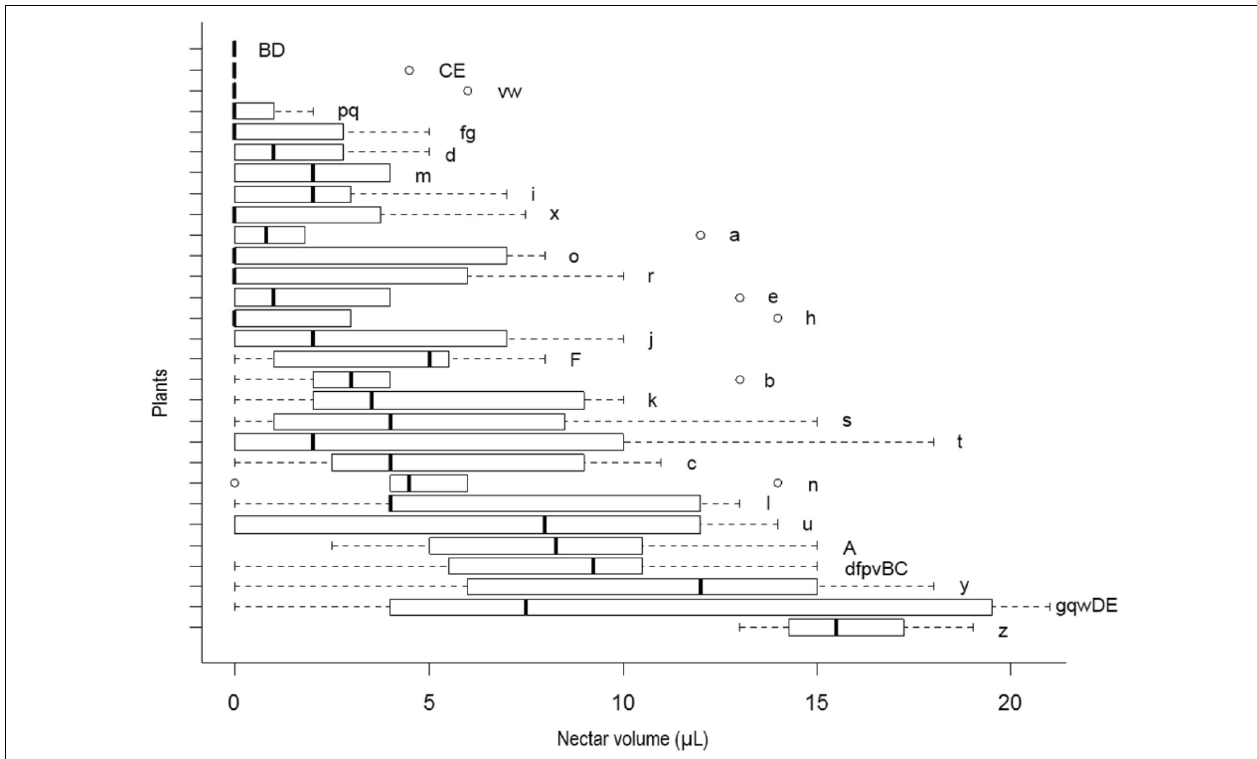
FIGURE 3 | Box plots of nectar volume variability per plant in J . oxyphylla . The box plots show the median (vertical line across the box), 25th and 75th percentiles (lower and upper edges of the box) and the upper and lower whiskers, which correspond to the higher and lower data that is no further from the box than 1.5 times the interquartile range. Any data that lied beyond the whiskers was considered an outlier (empty circles). Nectar volumes significantly different from one plant to another are denoted by different letters on the right side of the boxes (ANOVA with Brown–Forsythe correction for heteroskedastic data and Games–Howell post hoc test). Nectar volume showed high variability within and among plants ( p < 0.05). Note that various plants presented flowers with no nectar and others presented outliers as